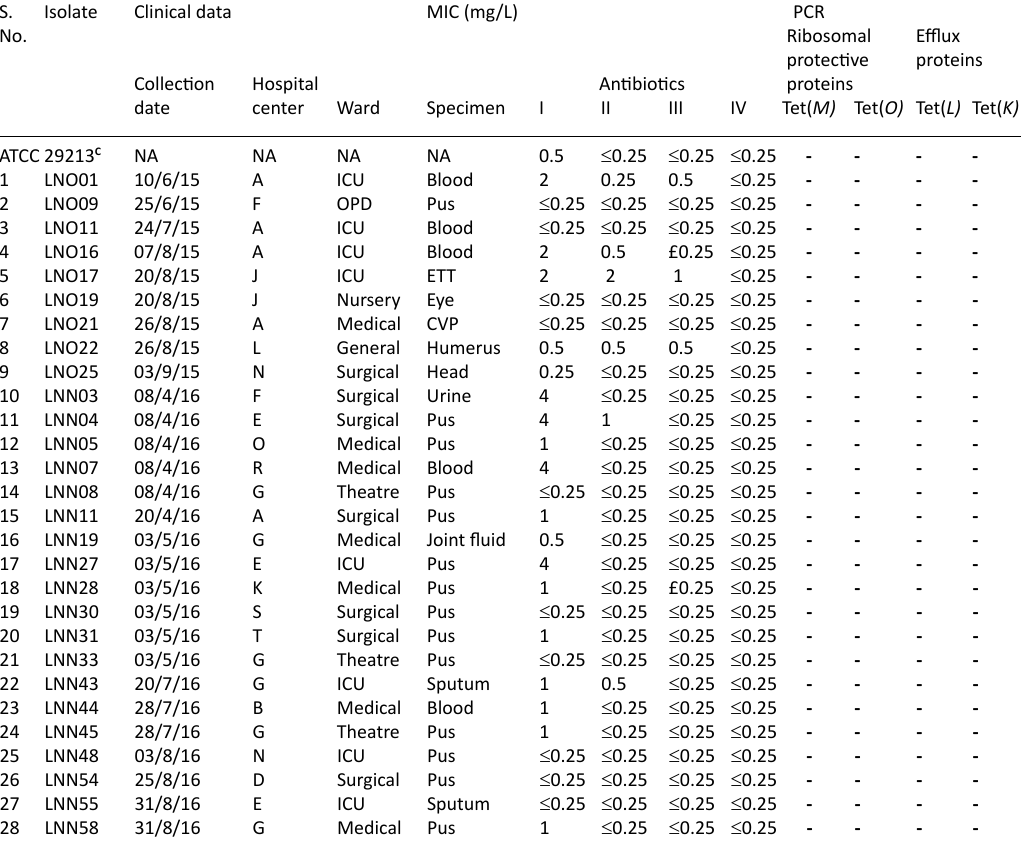
table s2: Clinical data and minimum inhibitory concentrations (MIC) for 28 tetracycline susceptible MRSA isolates